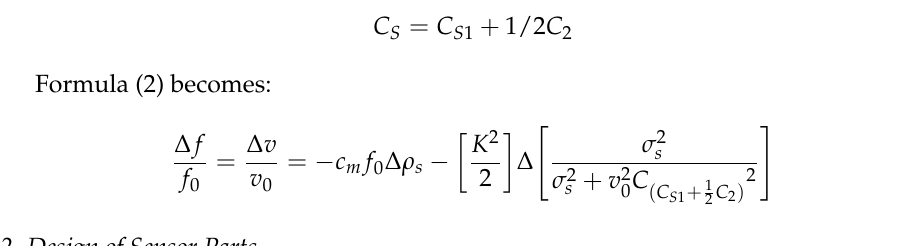
Figure 1. Equivalent circuit model: ( a ) Physical model; ( b ) Equivalent circuit.